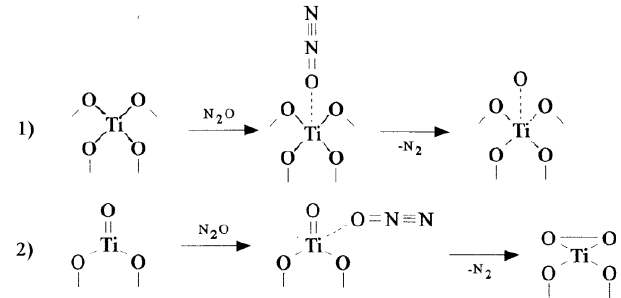
Figure 3. Representative XP spectra: (1) TS-1(I) (Si/Ti = 14.4); (2) TS-1 (II) (Si/Ti = 22.9); (3) TS-1(III) (Si/Ti =